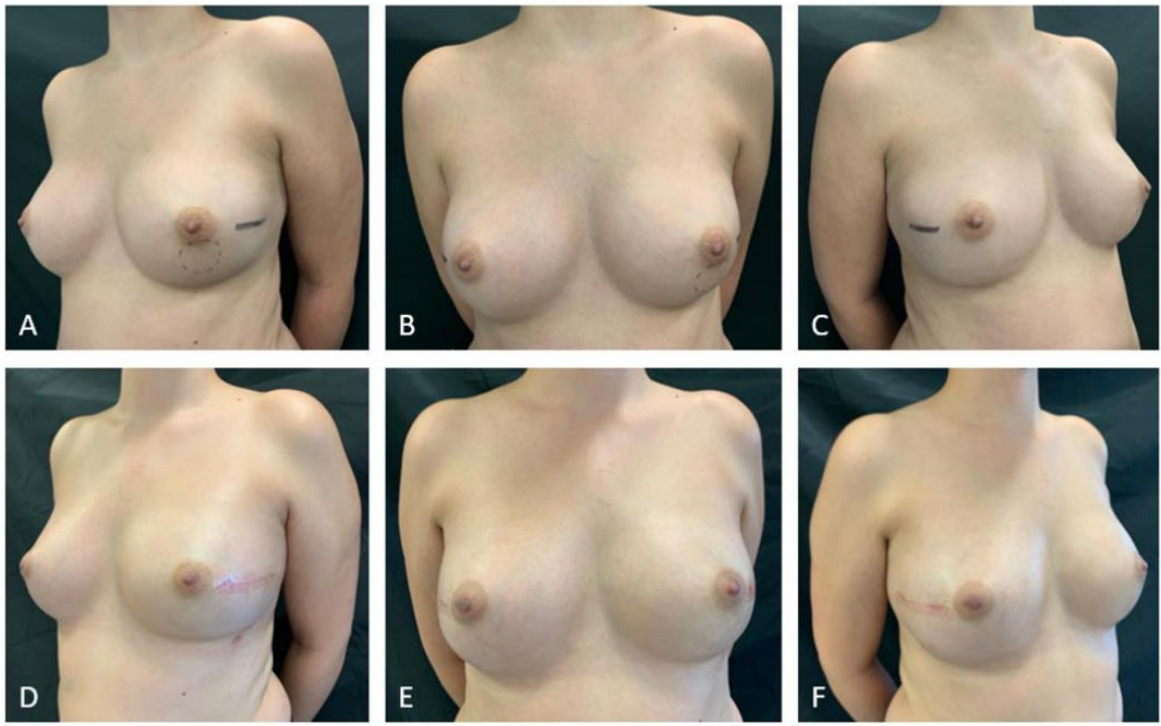
Figure 1. Pictures of a 45-year-old bilateral breast cancer patient. ( A–C ) Preoperative pictures. ( D–F ) Three-month postoperative pictures after bilateral nipple-sparing mastectomy and direct-to-implant prepectoral reconstruction after NAC.